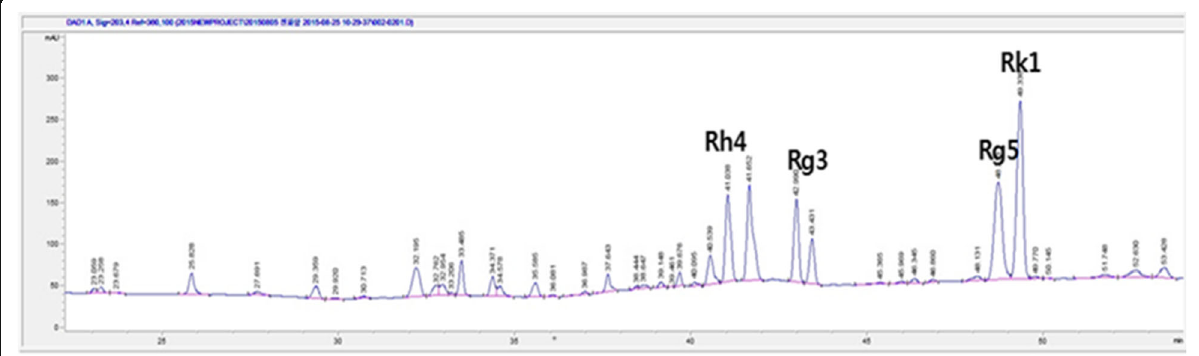
Fig. 1 HPLC chromatograns of ginsenosides in